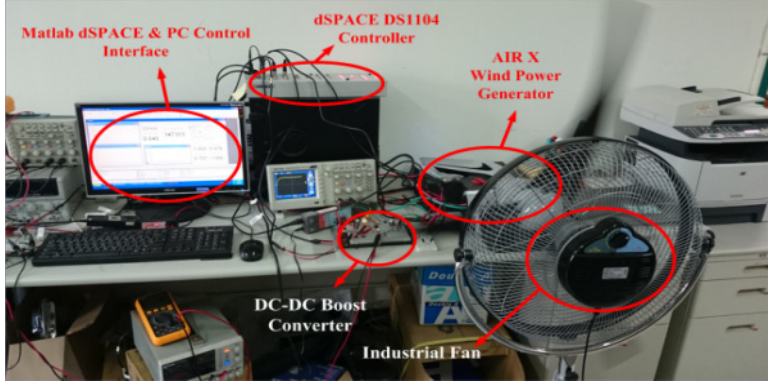
Figure 21. The maximum power point tracking real-time status diagnosis system hardware.